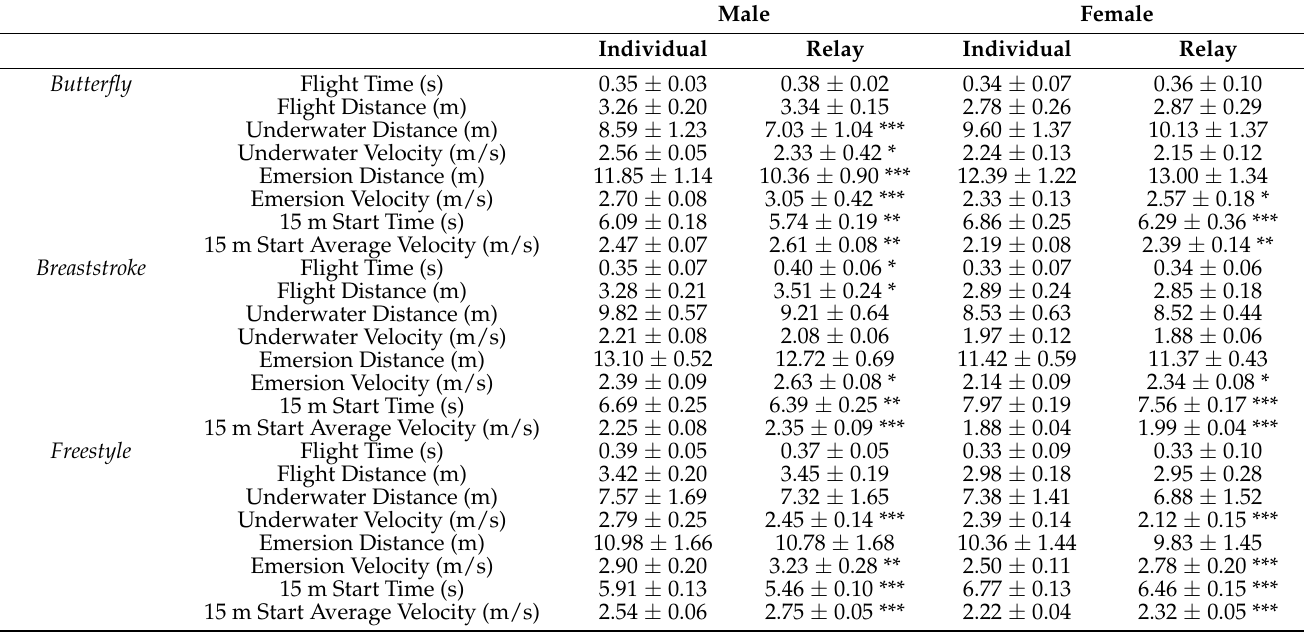
Table 1. Comparisons of start parameters between individual and relay events in the LEN European Junior Swimming Championships.